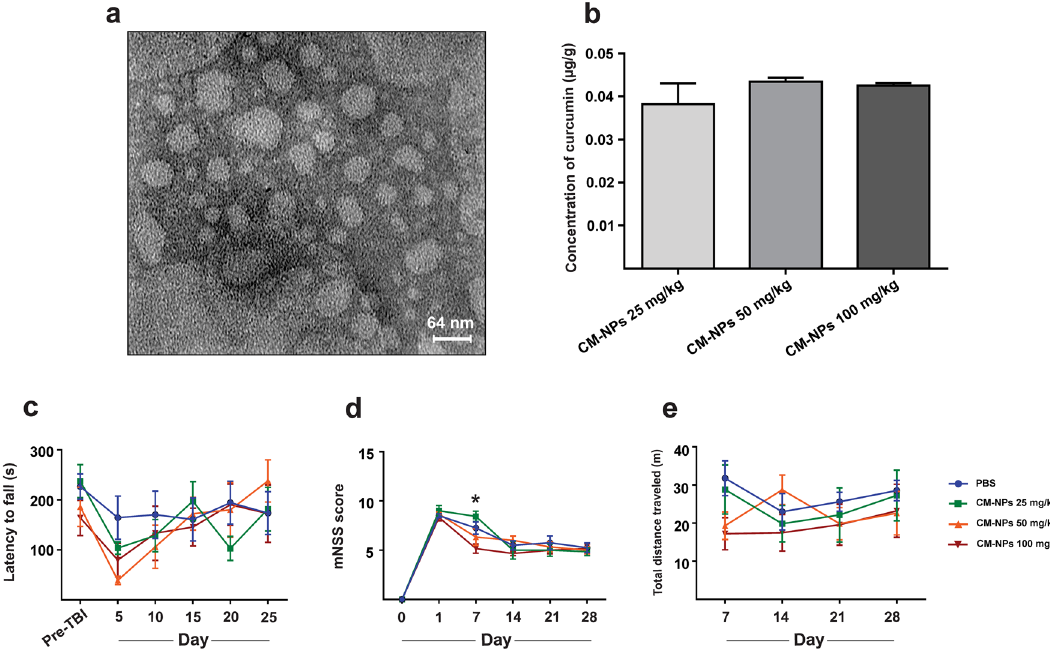
Figure 2. Characterization of CM-NPs. ( a ) Transmission electron microscopy (TEM) image of CM-NPs showed particles with spherical morphology and an average size of 60 nm. ( b ) The HPLC system was used to evaluate the ability of penetration of CM-NPs into the brain tissue. The representative micrograph shows different concentrations of curcumin in nanoparticles (i.e., 25, 50, and 100 mg/kg; n = 3). To find out an optimum dose of CM-NPs, some behavioral assessments, such as rotarod, mNSS, and OF were performed to evaluate the advanced locomotor function, sensory-motor function, and general loco-motor activity, respectively. ( c ) The rotarod test was performed before TBI as well as during predetermined time points after TBI. There was no significant difference for mean latency to fall between groups in the rotarod test. ( d ) The mNSS test was performed before TBI and predetermined time points after TBI in different groups. The mNSS score in the treated group with 50 mg/kg of CM-NPs was significantly decreased compared to 25 mg/kg of CM-NPs on day 7 after TBI. ( e ) Evaluation of total distance traveled in the open field in different groups on days 7–28 after TBI. The statistical analysis showed no significant difference for total distance traveled in the OF between groups. Data represented as the mean ± SEM and * indicates P < 0.05 (n = 6).